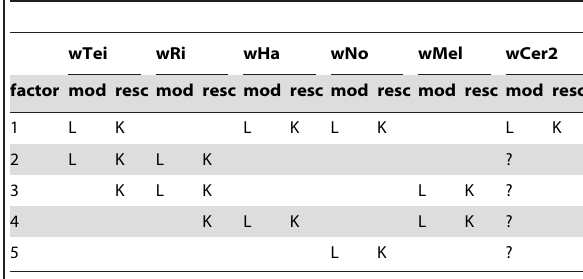
Table 2. Explanation of the compatibility relationship using the